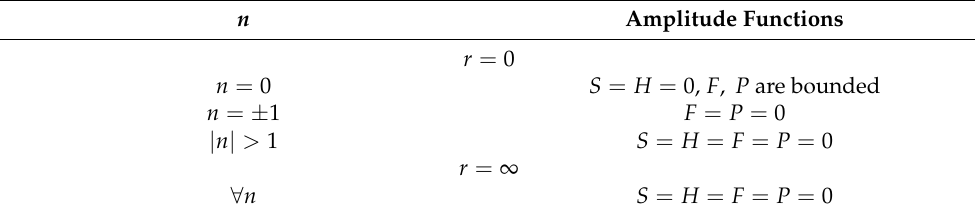
Table 1. The boundary